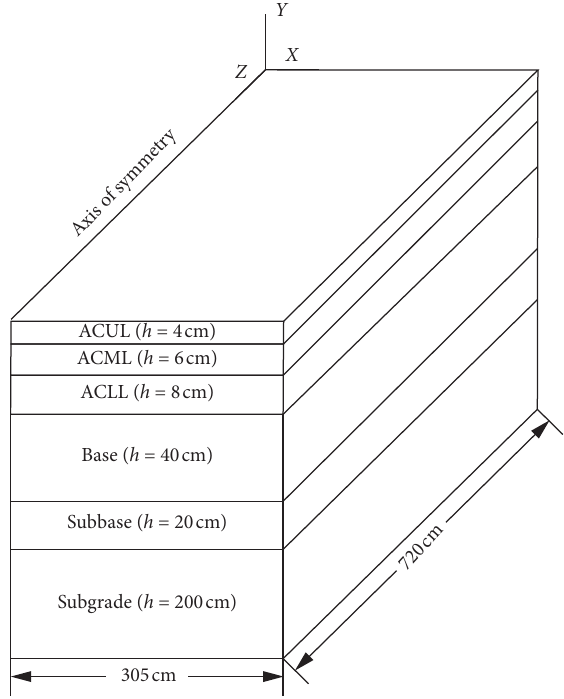
Figure 1: Semi-rigid base asphalt pavement structure (not to